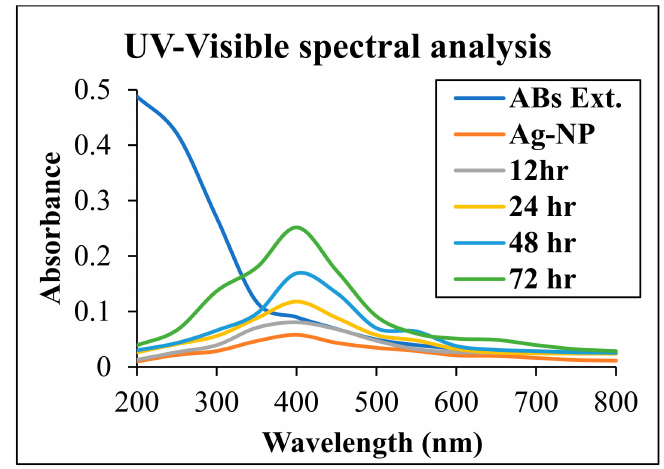
Figure 2. UV–Visible spectrum at different time durations.